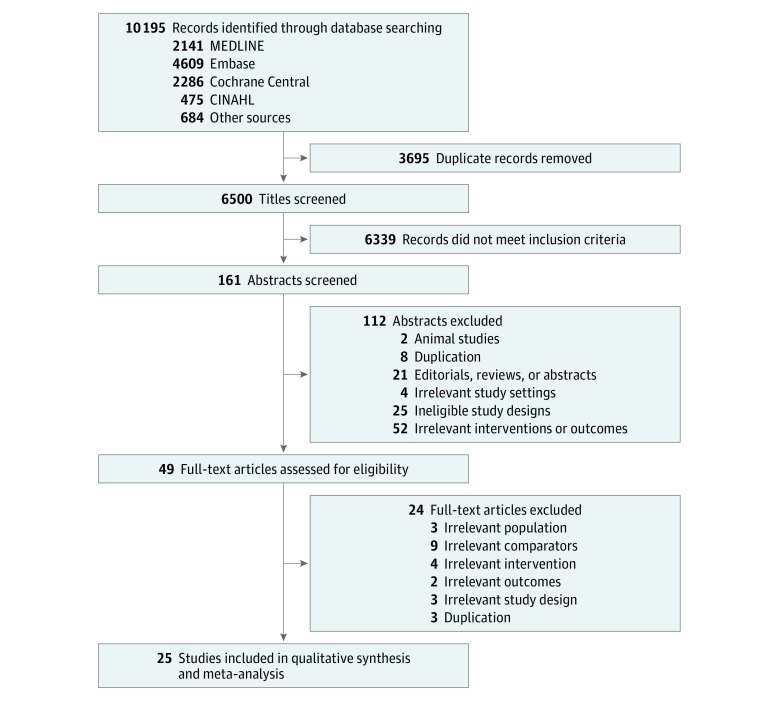
PRISMA Flow Diagram